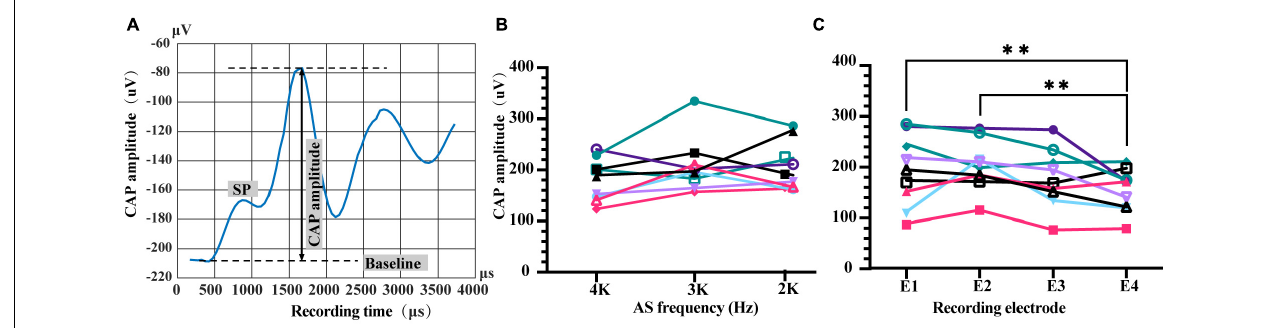
FIGURE 2 | Characteristics of intracochlear electrocochleography (iECochG) using different recording electrodes and AS frequency. (A) An example of iECochG recorded. Baseline is a horizontal line starting from the initial point of SP. CAP amplitude is determined as the distance from CAP peak to baseline. SP, summating potential; CAP, compound action potential. (B) CAP amplitudes of 20 dB AS with frequencies of 4, 3, or 2 kHz were comparable when recorded by number 1 electrode, F (2,16) = 2.553, P = 0.1090. (C) Recorded CAP amplitudes of 4 kHz/20 dB AS by different electrodes were significantly different, F (3,24) = 4.956, P = 0.0081. CAP amplitudes recorded by the most basal electrode E4 were significantly lower than those recorded by E1 and E2, P = 0.0068 and 0.0016, respectively. Repeated measure one-way ANOVA with Fisher’s LSD multiple comparisons. The lines with different colors in (B,C) represent different animals. ** P <